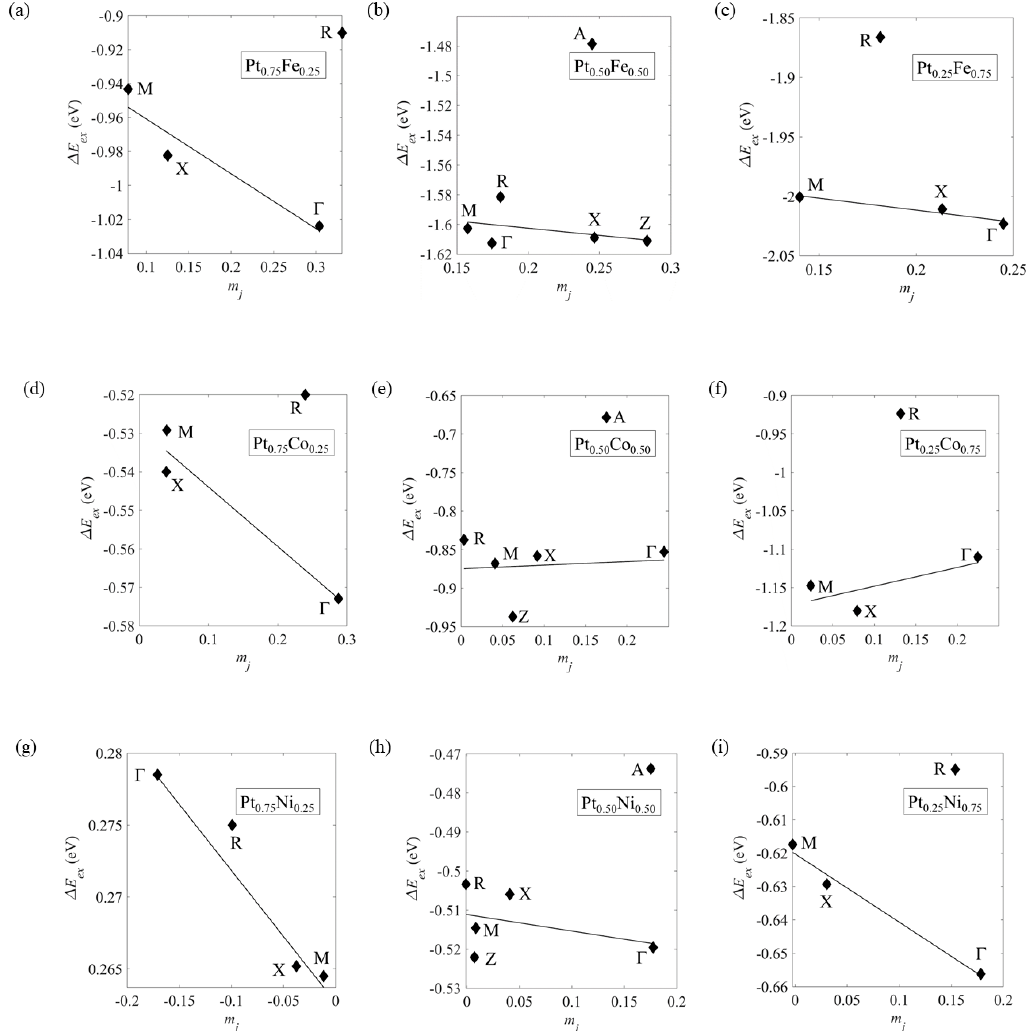
Figure 3. Exchange splitting ∆ E ex for the ordered ( a – c ) Pt x Fe 1 − x , ( d – f ) Pt x Co 1 − x and ( g – i ) Pt x Ni 1 − x ordered alloys. The labels correspond to high symmetry positions in the electron band structure, and m j is the normalized total magnetic moment. The line included in each graph is a guide for the eye.